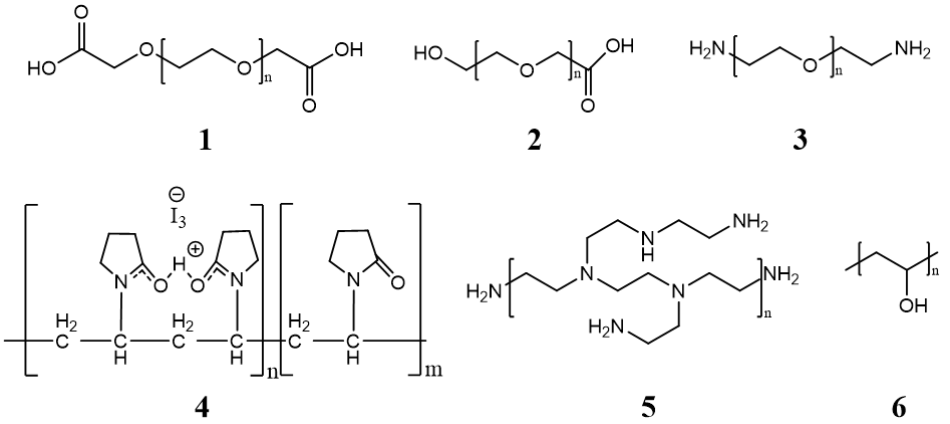
Figure 3. Polymers are used to coat the core of micelles. 1 , 2 , 3 : Polyethylene glycol (PEG) with functional groups at the ends (COOH, OH − , − NH 2 , etc.) [4,32,33]. 4 : Poli (N-vinyl-2-pyrrolidone) (PVP) [34], 5 : branched polyethyleneimine (PEI) [26], 6 : poly (vinyl alcohol) (PVA) [35].